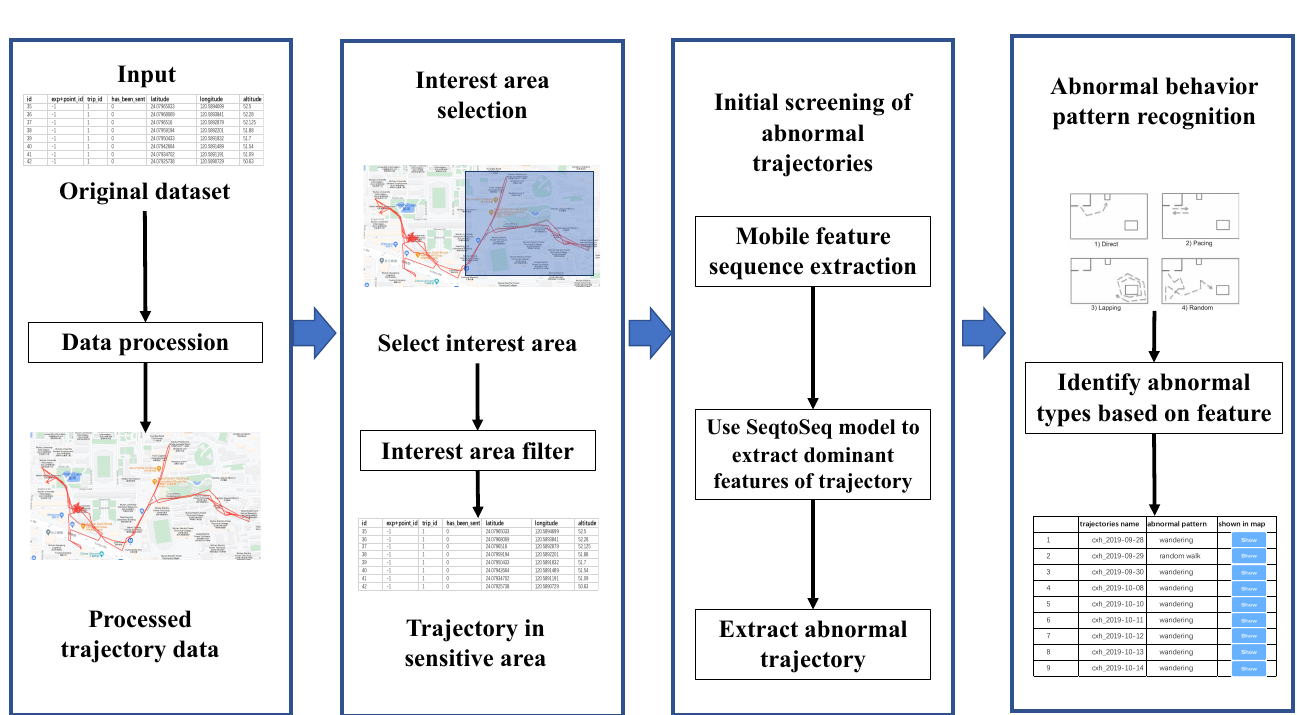
Figure 1. The overall flow of our